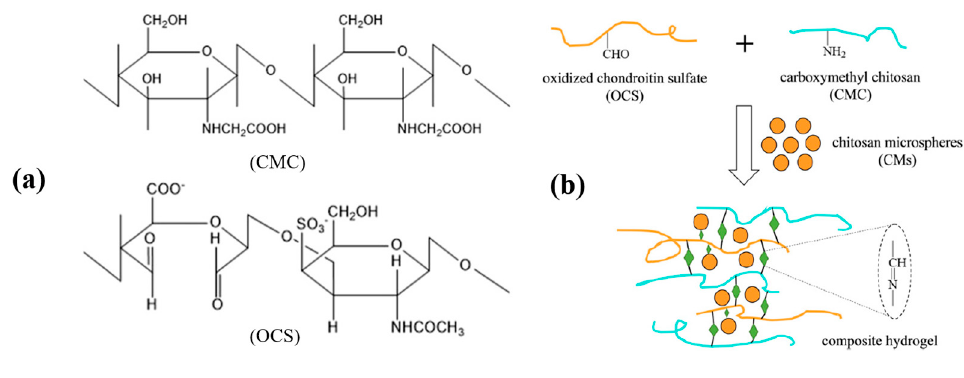
Figure 2. ( a ) Chemical structures of carboxymethyl chitosan (CMC) and oxidized chondroitin sulfate (OCS). ( b ) Reaction scheme to show a preparation of chitosan-based microspheres (CMs) embedded in CMC–OCS composite gel scaffold (CMs/gel). Modified from [21].